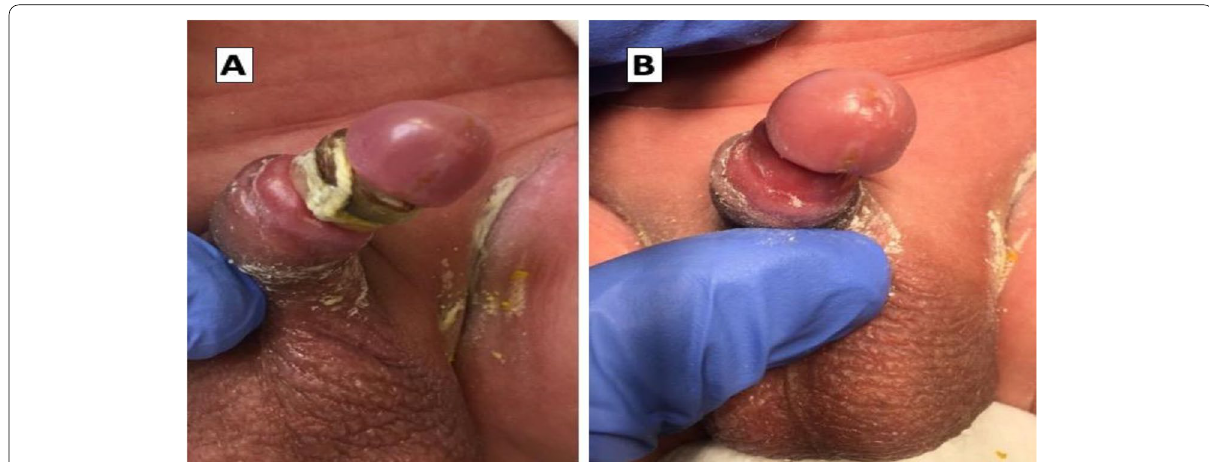
Fig. 1 Four-month-old child: A 2 weeks post circumcision show a proximal migration of Plastibell with its constriction effect with swelling in the glans penis and B immediately after Plastibell removal